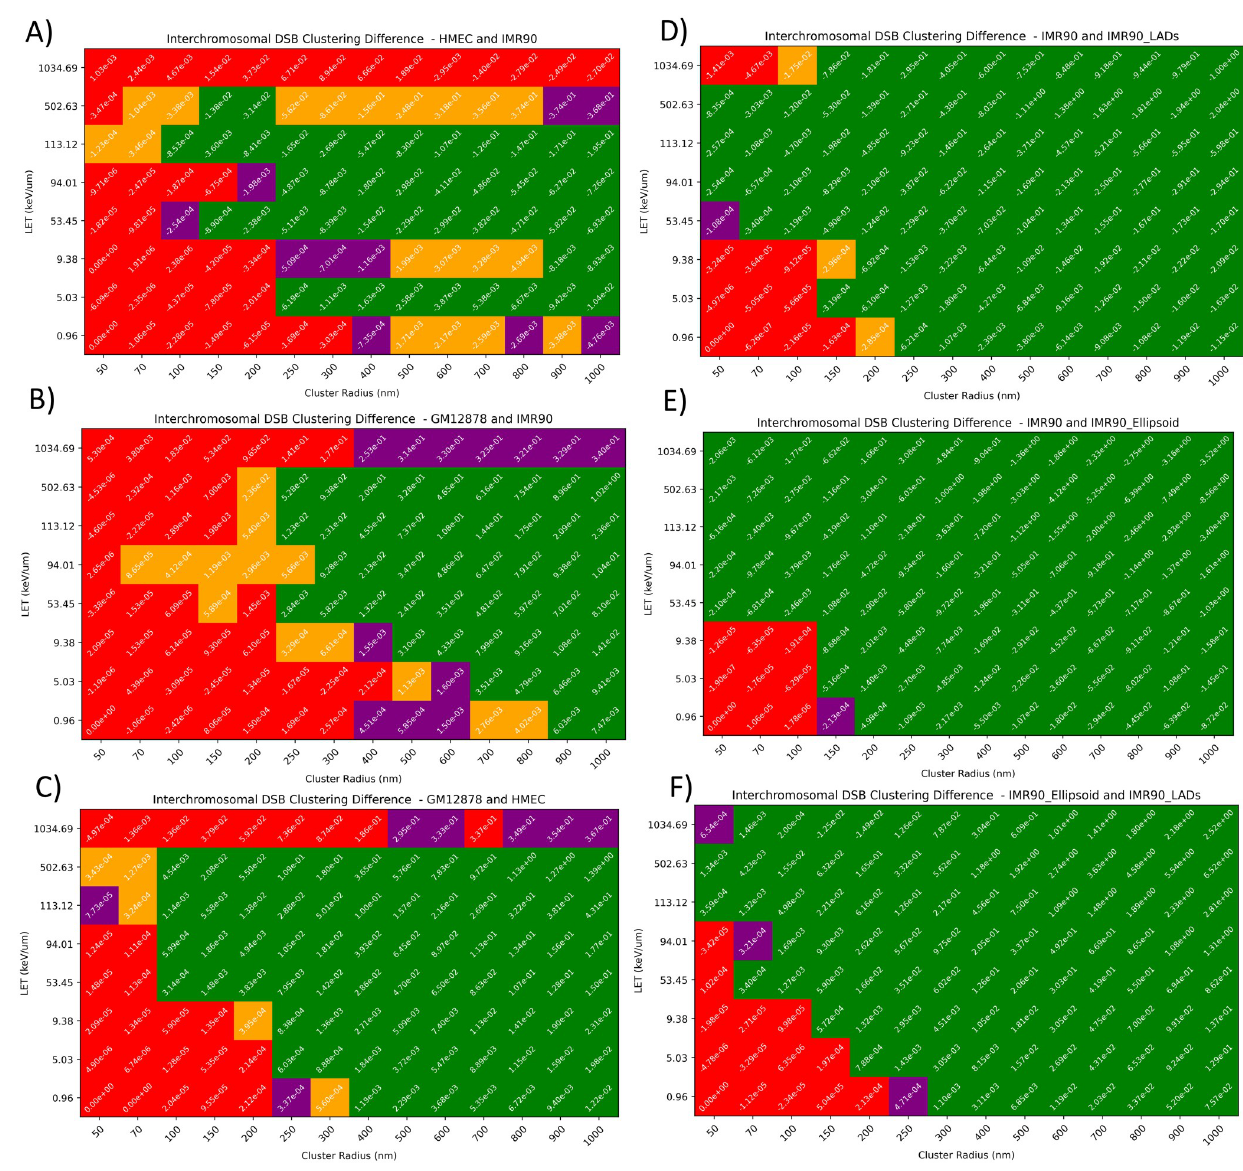
Fig 7. Examination of statistically significant change in interchromosomal DSB clustering between cell-types (A—C)) and variants (D)—F)). The values of the heat maps is the difference in the average interchromosomal clustering between the two cell types. The heat maps colouring shows the false discovery rate adjusted P-values from the Kolmogorov–Smirnov two-sided test for the full range of LET (keV/ mu m) and cluster radius (nm). The null hypothesis of the test is that two independent samples are drawn from the same continuous distribution. Colour codeing for adjusted P-values at varying thresholds: red (P > 0.05), purple (0.05 > P > 0.01), yellow (0.01 > P > 0.001) and green (P < 0.001). In this case, distributions with adjusted P- values < 0.05 are considered as statistically significantly different. Each of the tested distributions had 200 geometries per cell-type or variant group. Each value of interchromosomal DSB cluster density is an averaged result which comes from 50 independent 1Gy exposures at the listed LET and cluster radius values.